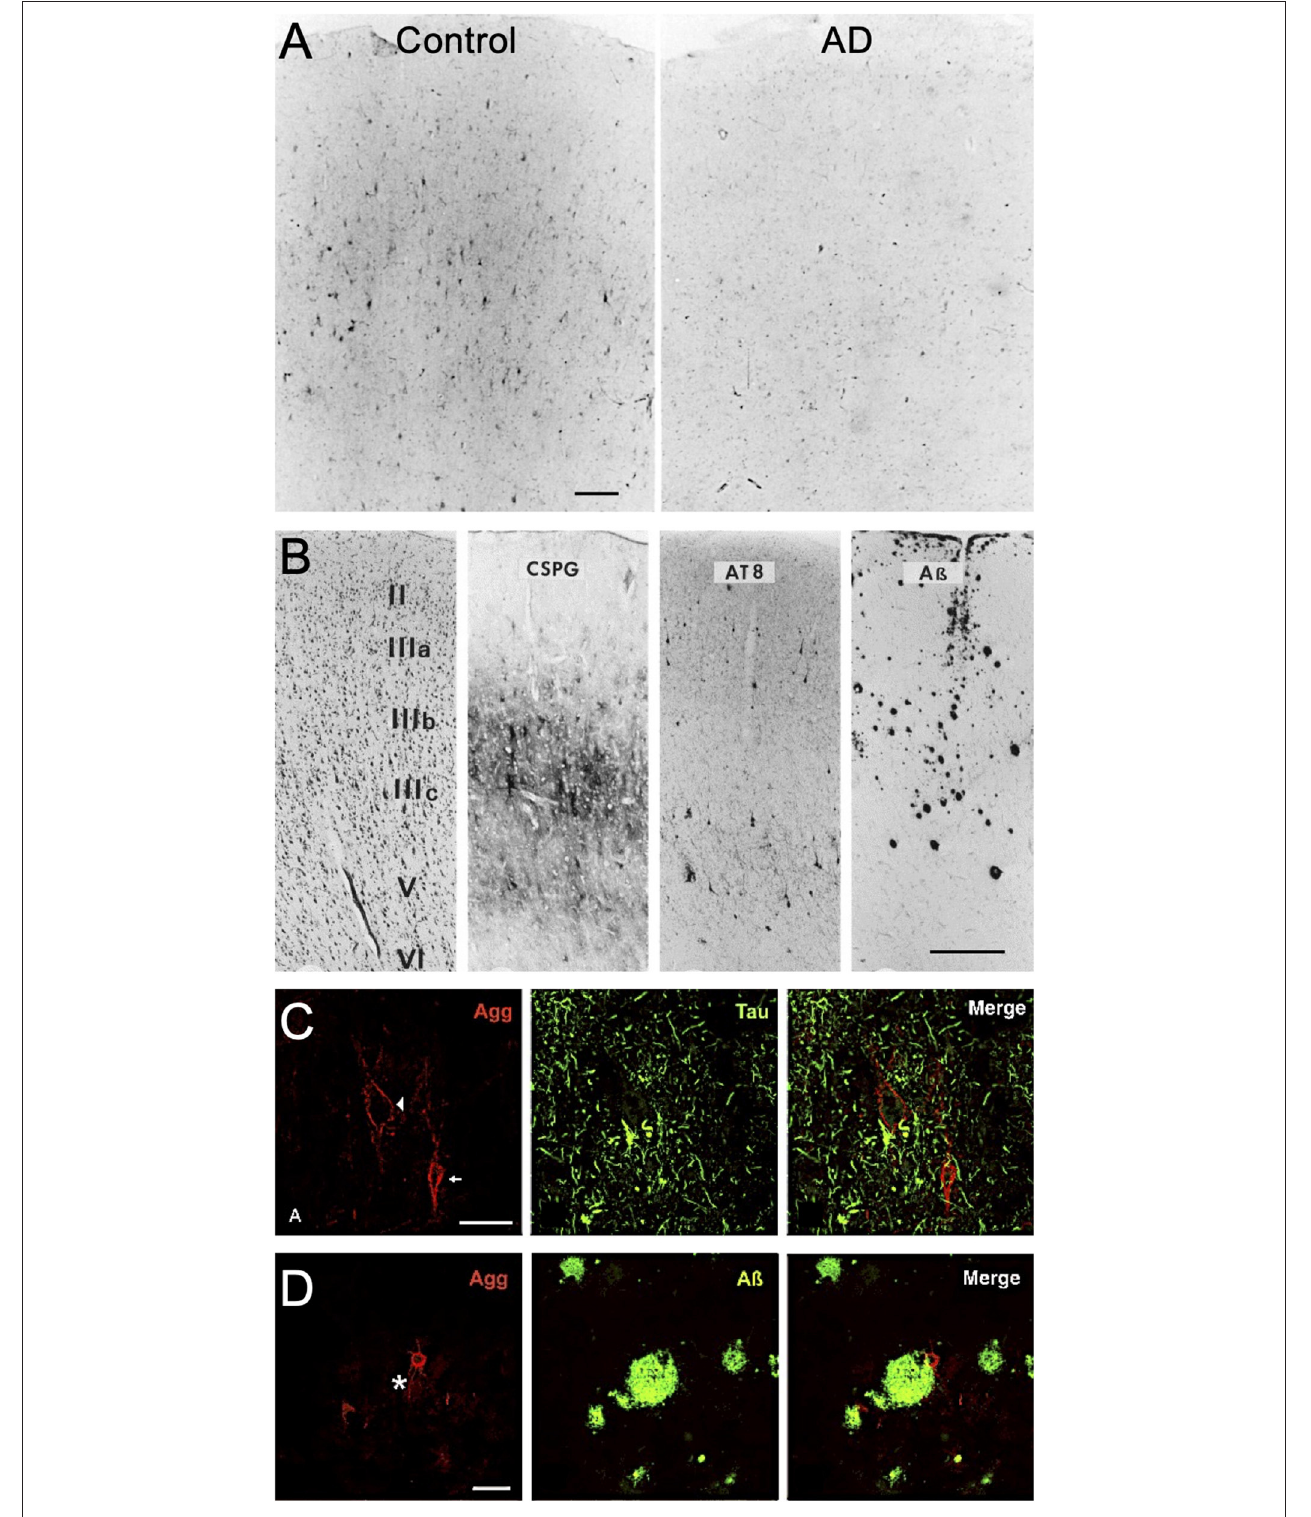
FIGURE 2 | PNN changes in AD postmortem brain tissue. (A) Vicia villosa lectin labeling of PNN glycans in postmortem frontal cortex is decreased in patients with AD. Scale: 150 µ m (see Kobayashi et al., 1989). (B) Laminar distribution of PNN CSPGs compared to AT8-labeling of pTau and ß-amyloid deposits in postmortem AD frontal cortex. Scale bar: 0.5mm (see Brückner et al., 1999). Aggrecan + PNNs are devoid of (C) pTau accumulation but show positive interactions with (D) ß-amyloid deposits (star indicates plaque location). Scale: 50 µ m (see Morawski et al., 2010a). CSPG, chondroitin sulfate proteoglycan; Agg, aggrecan.